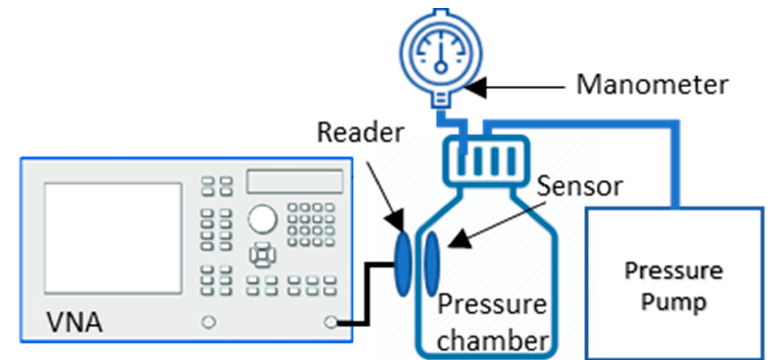
Figure 5. Bench test setup for sensor validation where reader coil is connected to vector network analyzer and sensor is kept inside the pressure chamber and pressure is varied using pressure pump.